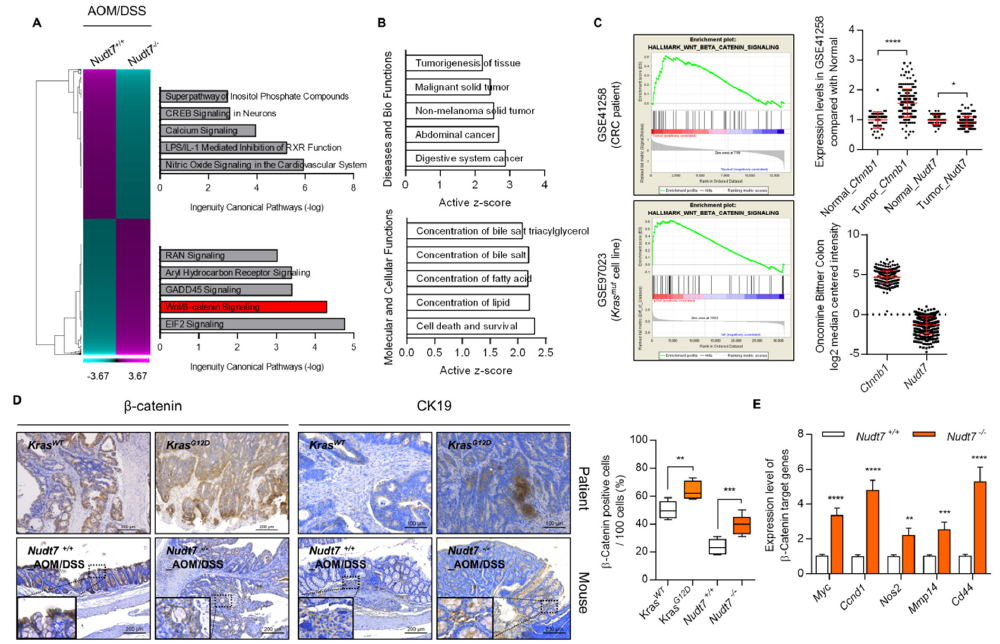
Figure 5. Suppression of Nudt7 increases β -catenin signaling. ( A ) Canonical pathway was analyzed using IPA software (Qiagen, Redwood, CA, USA) from microarray data of Nudt7 +/+ and Nudt7 − / − colons treated with AOM / DSS. ( B ) Active z -score of disease and biological functions or molecular and cellular functions were analyzed using IPA software. ( C ) GSEA analysis using GEO datasets (CRC patient biopsy dataset, GSE41258 and Kras G12D mutation CRC cell line dataset, GSE97023) and expression levels of Nudt7 and Ctnnb1 . ( D ) Immunohistochemical staining with β -catenin and CK19 and positive cell count in Nudt7 +/+ and Nudt7 − / − mice treated with AOM / DSS ( n = 4; 100 × magnification; scale bars: 200 µ m) and Kras G12D -derived CRC patient ( n = 4; β -catenin, 100 × magnification, scale bars: 200 µ m; CK19, 200 × magnification, scale bars: 100 µ m) and positive cells were counted for every 100 cells in 3 di ff erent fields. CK19 was used as a marker for epithelial tissue. Results are representative of at least 3 independent experiments. The dotted line boxes were enlarged in the bottom left corner of each image. ( E ) Transcriptional levels of β -catenin target genes and presented as the fold change compared with Nudt7 − / − mice. Rn18s was used as an endogenous control. Results are representative of at least 3 independent experiments. Values are means + SD. An unpaired Student’s t -test was used for statistical analysis. * p ≤ 0.05, ** p < 0.01, *** p < 0.01, **** p <